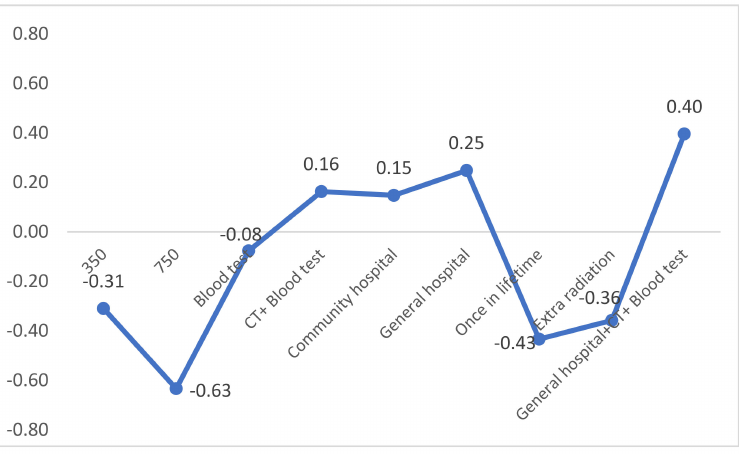
Figure 2. Uptake rate under different screening modalities. Opt-out was chosen as the most preferred of the three options in each choice set by 7.89% of all respondents, indicating an extremely low willingness to participate in a screen-